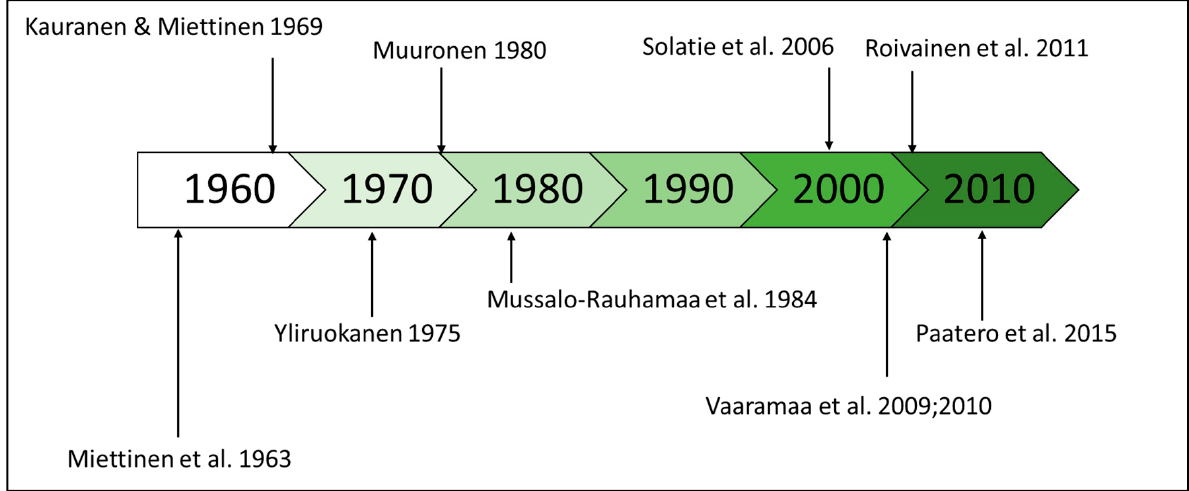
Figure 7. Timeline of the most significant steps in natural radionuclide studies in terrestrial environment in respect to food chains in Finland.